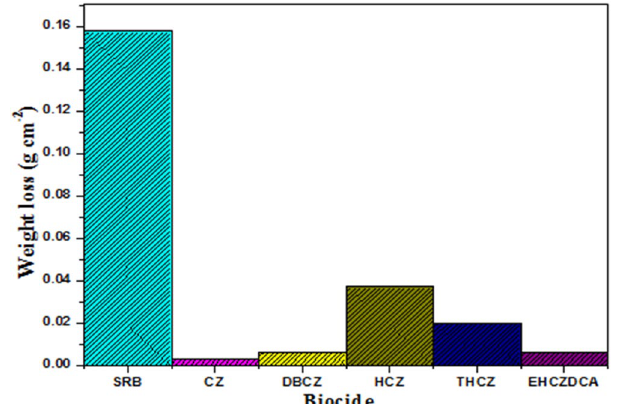
Figure 6. Weight loss measurements for mild steel exposed to SRB cultures after 9 days incubation with or without 100 ppm carbazoles at 310 K.